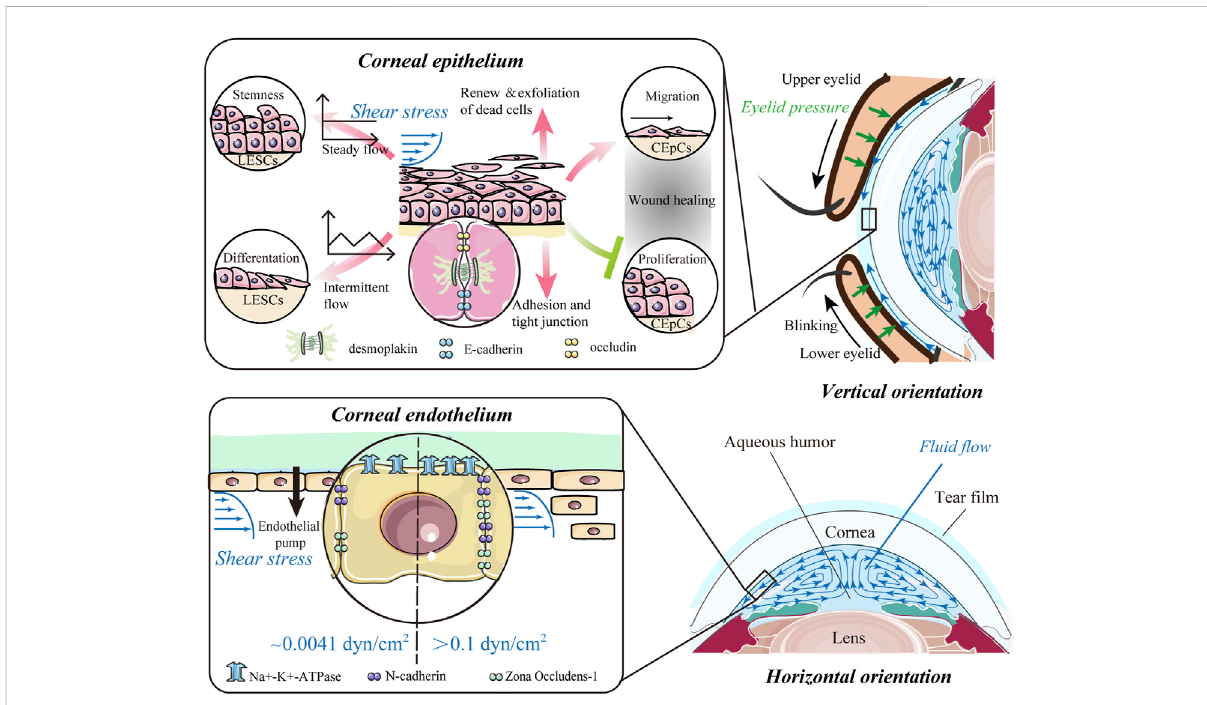
FIGURE 2 Impact of shear stress. The fl ow of the tear fi lm and aqueous humor potentially results in shear stress on the anterior and posterior surfaces of the cornea and predominantly affects the epithelium and endothelium of the cornea. For corneal epithelial cells (CEpCs), steady fl ow maintains limbal epithelial stem cell (LESC) stemness, whereas intermittent fl ow induces their differentiation. Shear stress is crucial for spontaneous renewal and exfoliation of super fi cial epithelial cells, while it also promotes cell – cell contacts to strengthen barrier function. In the wound healing process, shear stress can mediate migration of CEpCs to facilitate wound healing, while suppressing proliferation of CEpCs to delay wound repair. Corneal endothelial cells (CEnCs) are more likely to be detached from the corneal endothelium with higher shear stress ( > 0.1 dyn/cm 2 ). Also,